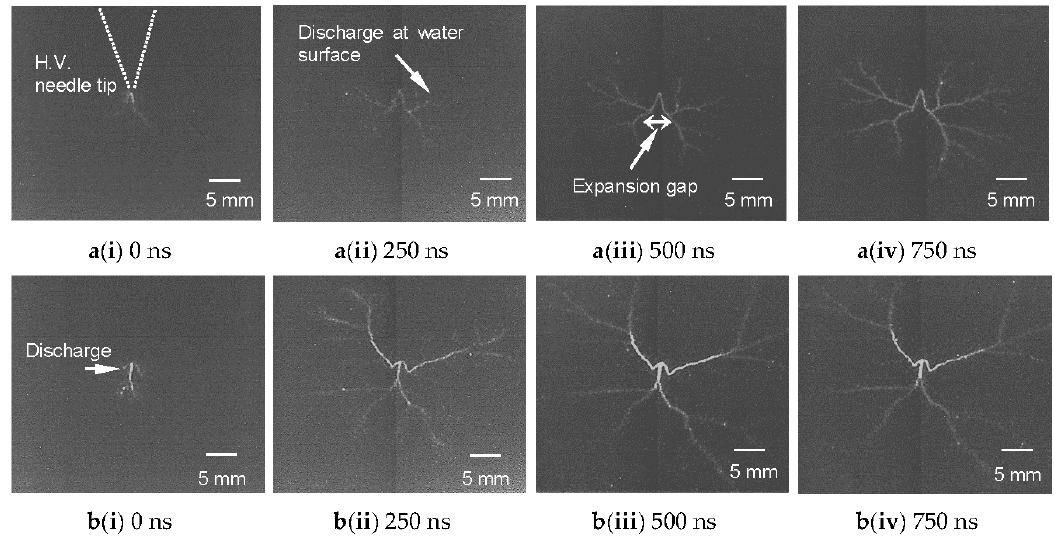
Figure 4. Real-time images of streamer captured by an ultra-high speed framing camera at applied voltage of ( a ( i – iv )) 11.6 kV, exposure time 150 ns; and ( b ( i – iv )) 21.6 kV, exposure time 50 ns; inter-frame rate 250 ns for both cases (scale bar = 5 mm).